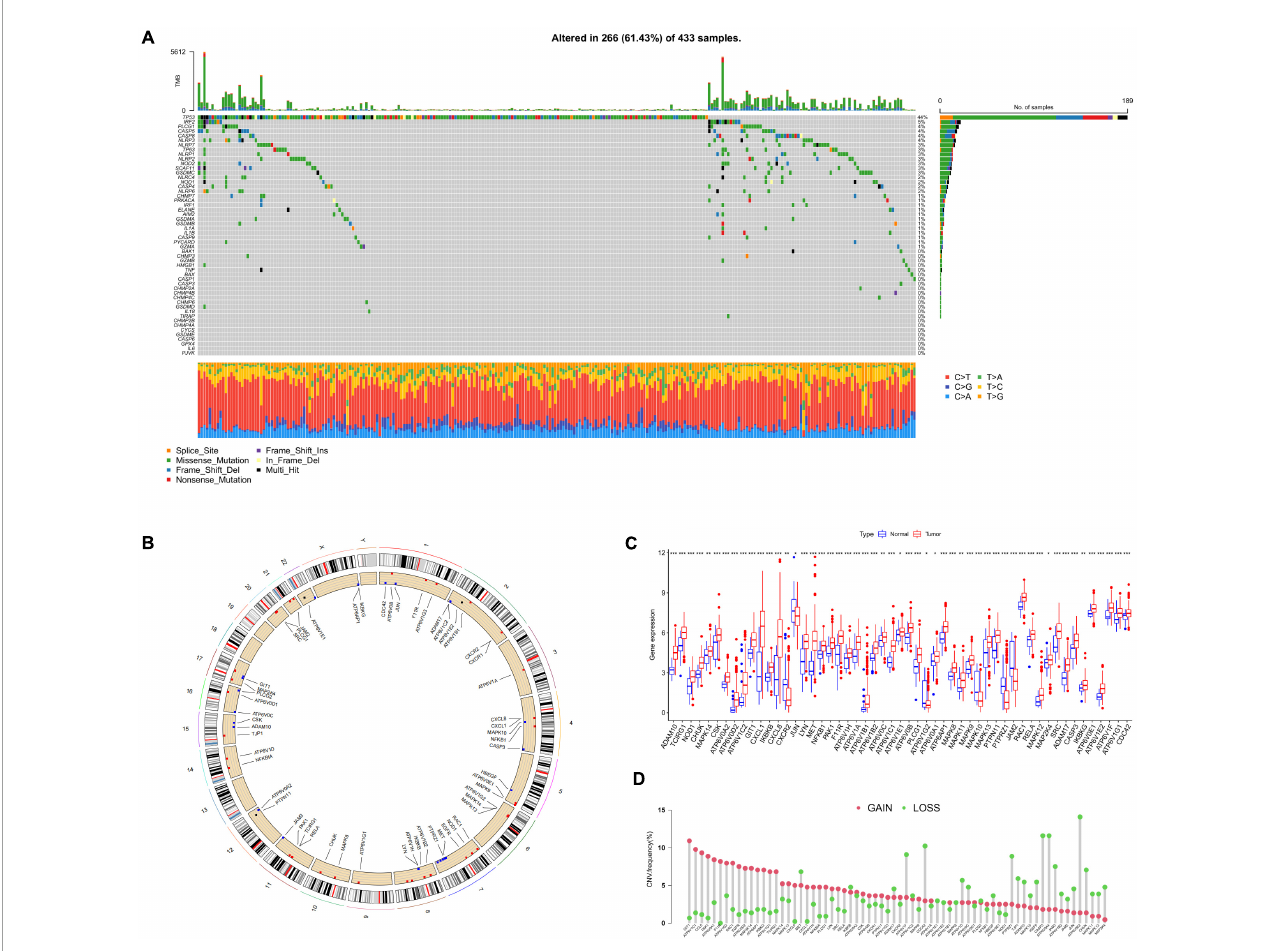
FIGURE2 The landscape of HRGs in GC. (A) Frequencies of mutation in 433 patients with GC in GEO and TCGA datasets. The mutation frequency of each gene was presented on the right. Every column represented a sample. (B) CNV alterations of HRGs on 23 chromosomes. The red dot represented the gain frequency while the green dot represented the loss frequency. (C) Expression distributions of 52 HRGs between normal and GC samples, * p < 0.05, ** p < 0.01, *** p < 0.001. (D) The CNV frequency of HRGs in all samples. HRGs, HP-related genes; GC, gastric cancer; GEO, Gene Expression Omnibus; TCGA, The Cancer Genome Atlas; CNV, copy number